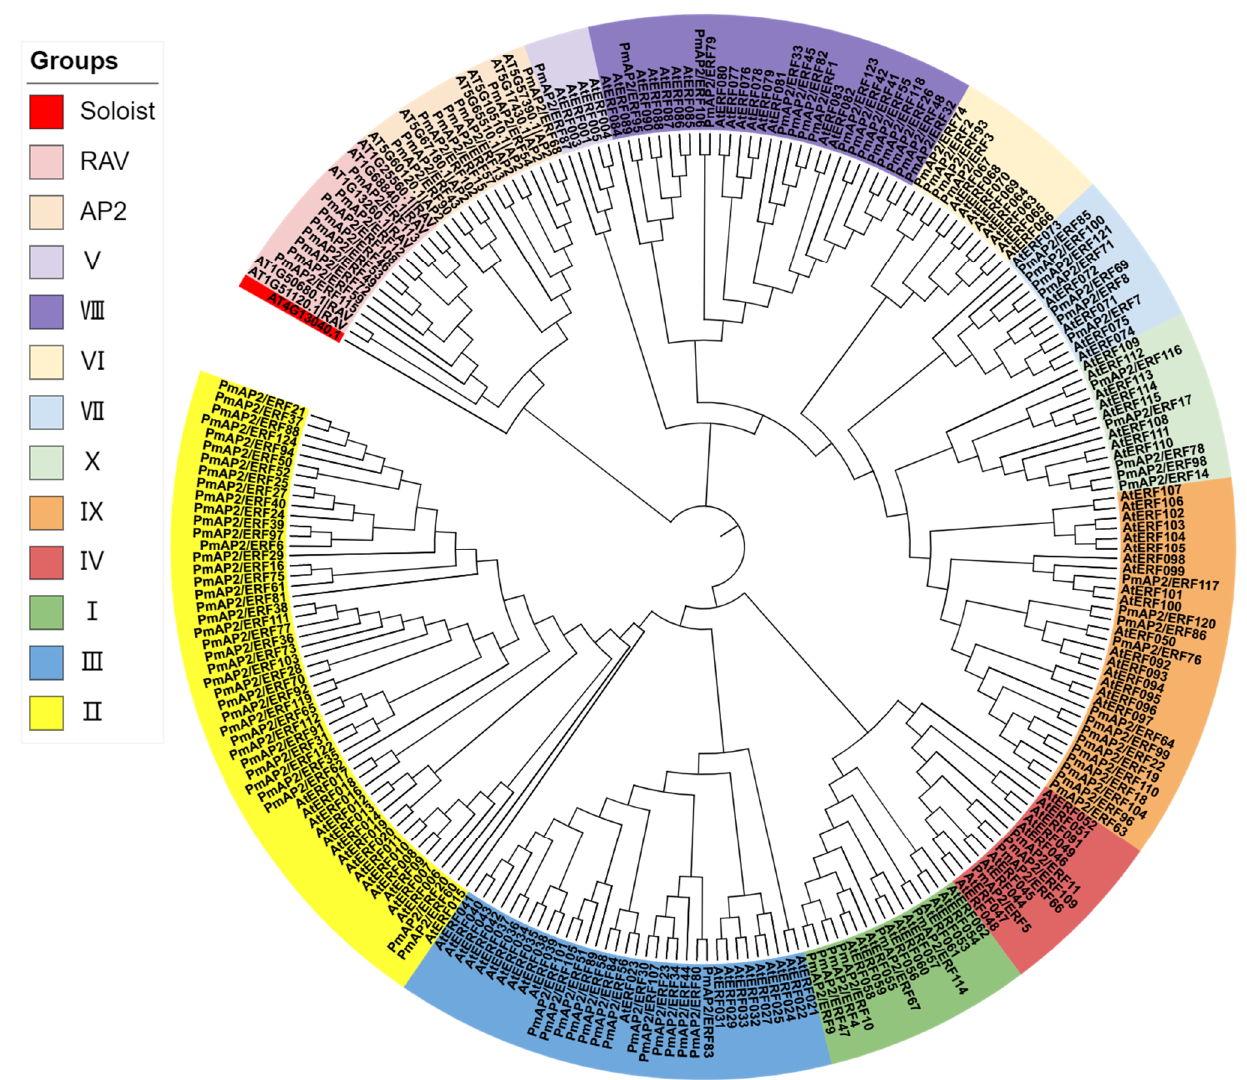
Figure 1. Phylogenetic analysis of PmAP2/ERFs proteins in P. massoniana . A. thaliana AP2/ERF pro- tein sequences were downloaded from TAIR database and PlantTFBD database, and the phylogenetic evolutionary trees of PmAP2/ERFs of P. massoniana and AtERFs of A. thaliana were constructed using MEGA7 software and iTOL, and different colors in the figure represent different groupings.